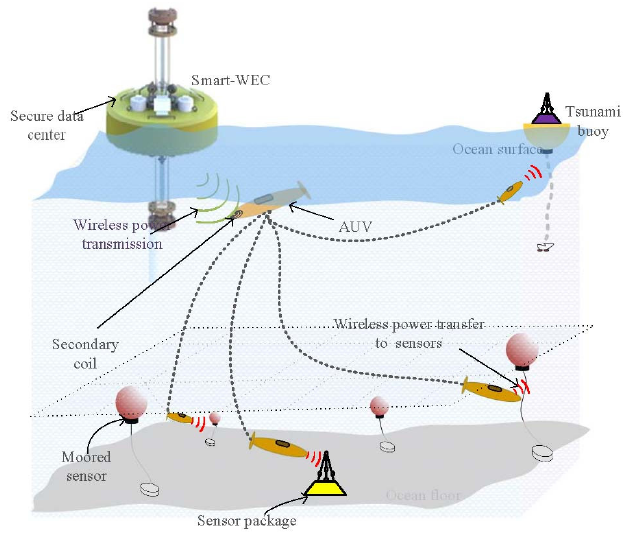
Figure 24. Concept of Smart Ocean Energy Systems [133].